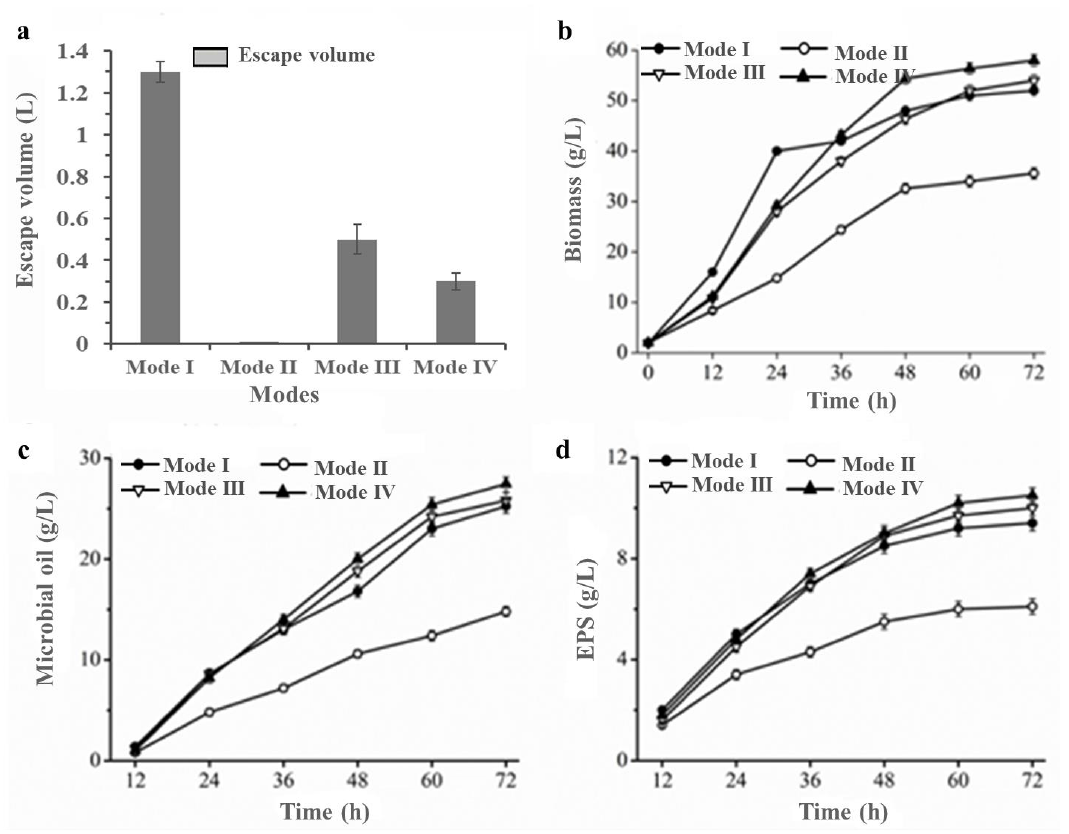
Figure 3. Effects of CSL feeding method on the fermentation of S. pararoseus JD-2. ( a ) The volumes of broth leakage in different modes of CSL feeding. ( b ) The biomass in different modes of CSL feeding. ( c ) The microbial oil concentration in different modes of CSL feeding. ( d ) The EPS concentration in different modes of CSL feeding. The data represent mean values and standard deviations obtained from three independent cultivations.